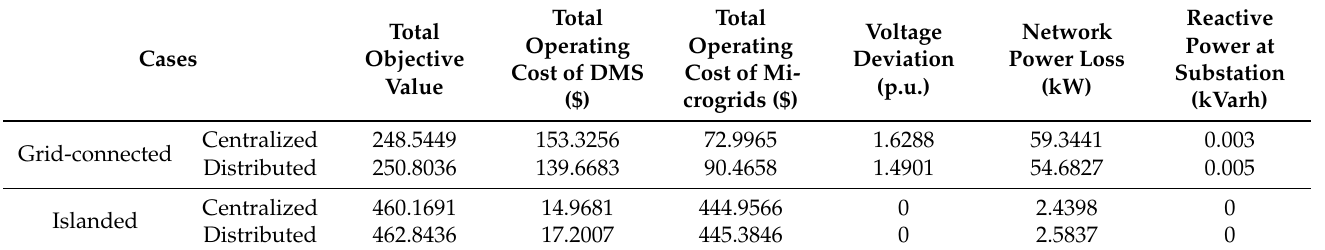
Table 5. Comparison of various objective values and costs in various